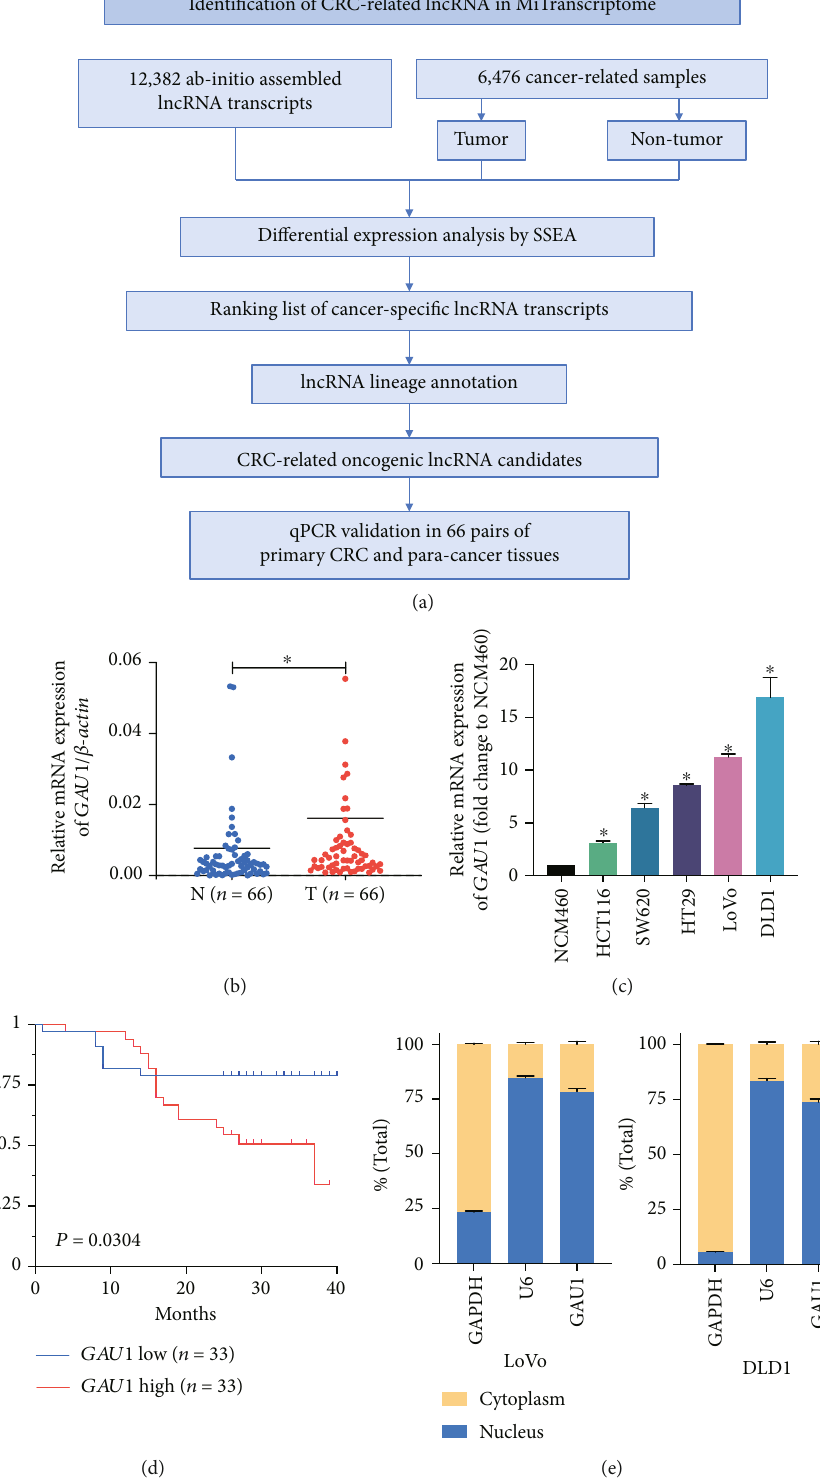
Figure 1: Identi fi cation of GAU1 as the colorectal cancer-related lncRNA. (a) The working pipeline of identifying CRC-related lncRNA in the MiTranscriptome database. (b) Relative expression level of GAU1 detected by qRT-PCR in 66 paired colorectal cancer (CRC) tissues and adjacent normal tissues ( P = 2 : 53 × 10 − 2 ). N: adjacent normal tissues; T: tumor tissues. (c) qRT-PCR analysis of GAU1 expression in the fi ve CRC cell lines and the normal NCM460 cells was tested. ∗ P < 0 : 05 . (d) Kaplan-Meier analysis of the correlation between GAU1 mRNA expression and overall survival in 66 CRC patients ( P = 3 : 04 × 10 − 2 ). (e) Total RNA from LoVo and DLD1 cells was separated into cytoplasmic and nuclear fractions and analyzed by qRT-PCR. GAPDH serves as a positive control for cytoplasmic gene expression, and U6 as a positive control for nucleolus